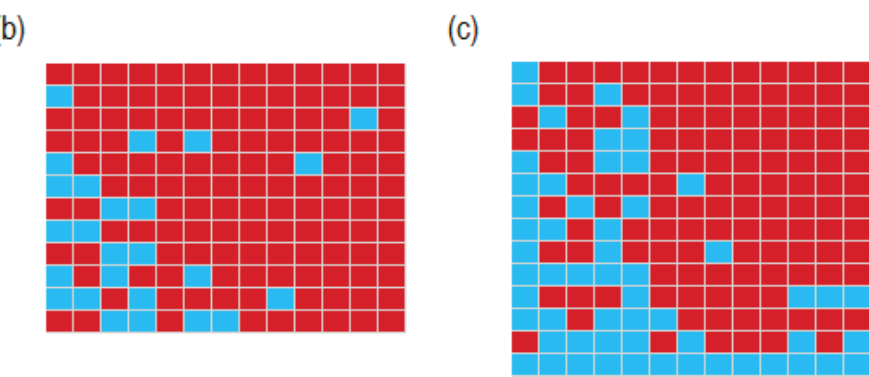
Figure 7. DNA methylation profiling of gpib in red skin and white skin. ( a ) The genome structure and predicted CpG Islands of gpib . The grey boxes symbolized exons of gpib and the spotted fold lines represented introns. The predicted CpG Islands were colored pink. The selected CpG Island for downstream BS-PCR analysis was shown in the green region; ( b ) DNA methylation status of gpib in red skin examined with BS-PCR analysis. Each row was a sequenced clone and a column represented a CpG site. The red boxes were methylated CpG sites and the blue boxes indicated the un-methylated CpG sites. The un-sequenced CpG sites were shown with the white boxes; ( c ) DNA methylation status of gpib in white